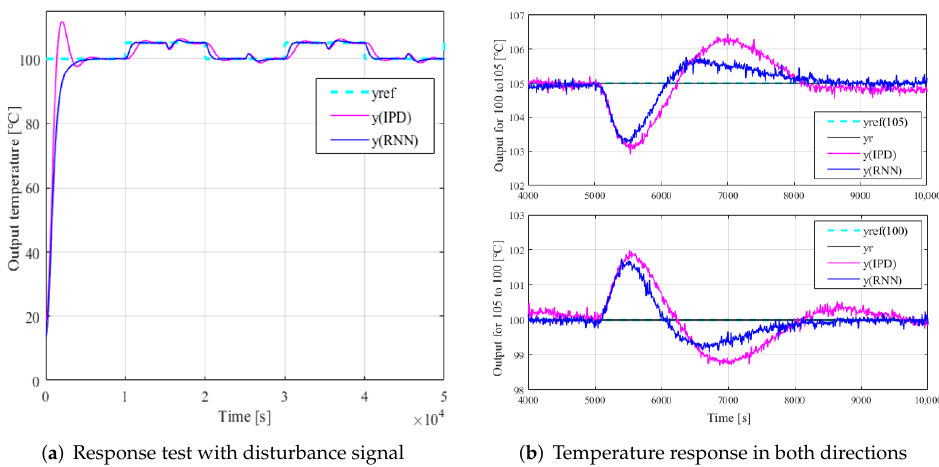
Figure 6. Dynamic response with a disturbance. ( a ) The whole disturbance response from tempera- ture to setpoint and periodic changes in different directions. ( b ) The local magnified responses after adding disturbance